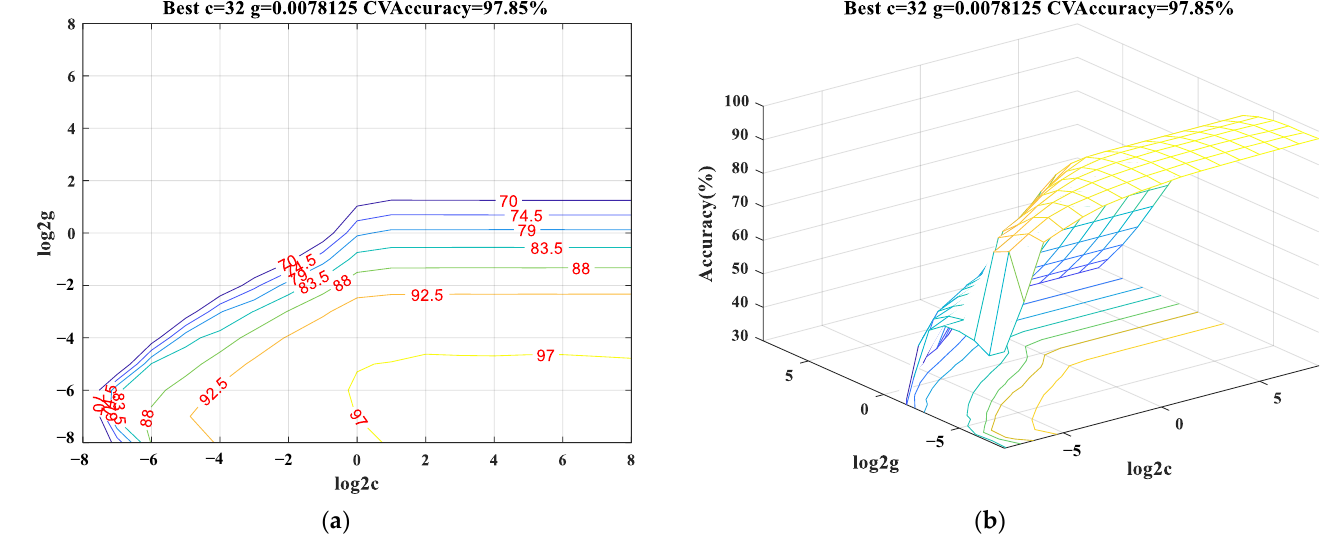
Figure 5. The support vector machine (SVM) model parameter selection for VMD-HT time-frequency-domain features training set ( a ) Contour map of SVM model parameter selection ( b ) 3D graphics of SVM model parameter selection.